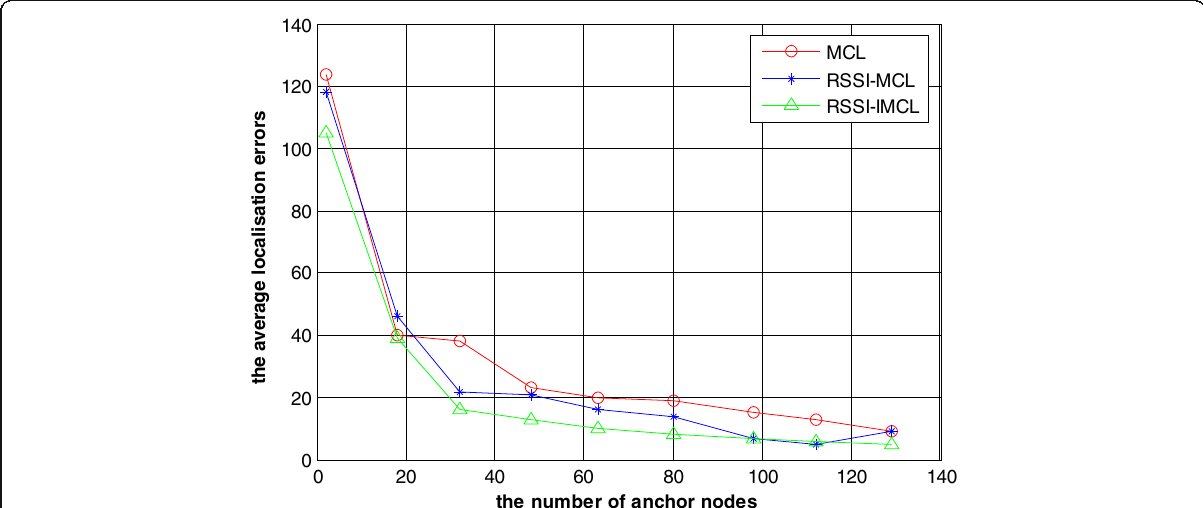
Fig. 3 Comparison of the average localization errors and the number of anchor